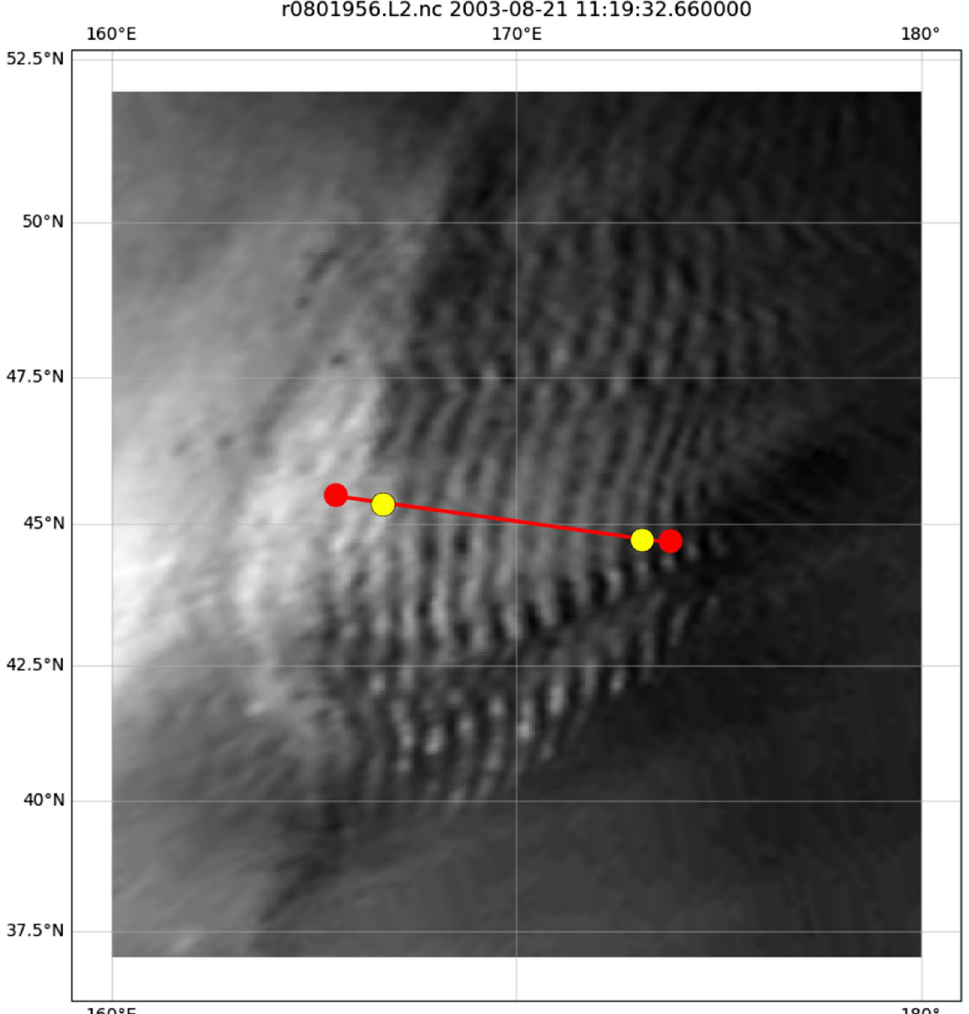
Fig. 3 The schematic view explaining the method for deriving the mean wavelength of the cloud train. The red circles indicate the two edge points of the cloud train that are determined so that the red line passing through them is as perpendicular as possible to the phase lines of the cloud streaks. The yellow circles indicate the most outside cloud streaks that can be visually detected on the red